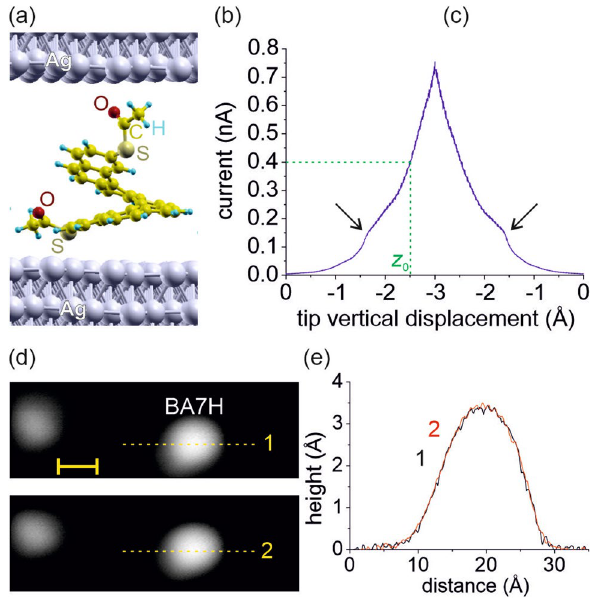
Figure 1. ( a ) DFT simulation of the SMJ formed by a single BA7H molecule covalently bound between two Ag electrodes. ( b , c ) Dependence of the current through the SMJ during formation ( b ) and breaking ( c ) of the SMJ by controlled variation of the STM tip-sample separation. ( d ) STM images (scale bar is 1 nm; tunnel conditions: + 0.5 V, 9 pA; z scale is 350 pm) of a single BA7H molecule before formation (top) and after breaking (bottom) of the SMJ. ( e ) Height profiles across the dashed lines labelled 1 and 2 in ( d ) obtained before formation of the SMJ and after breaking the